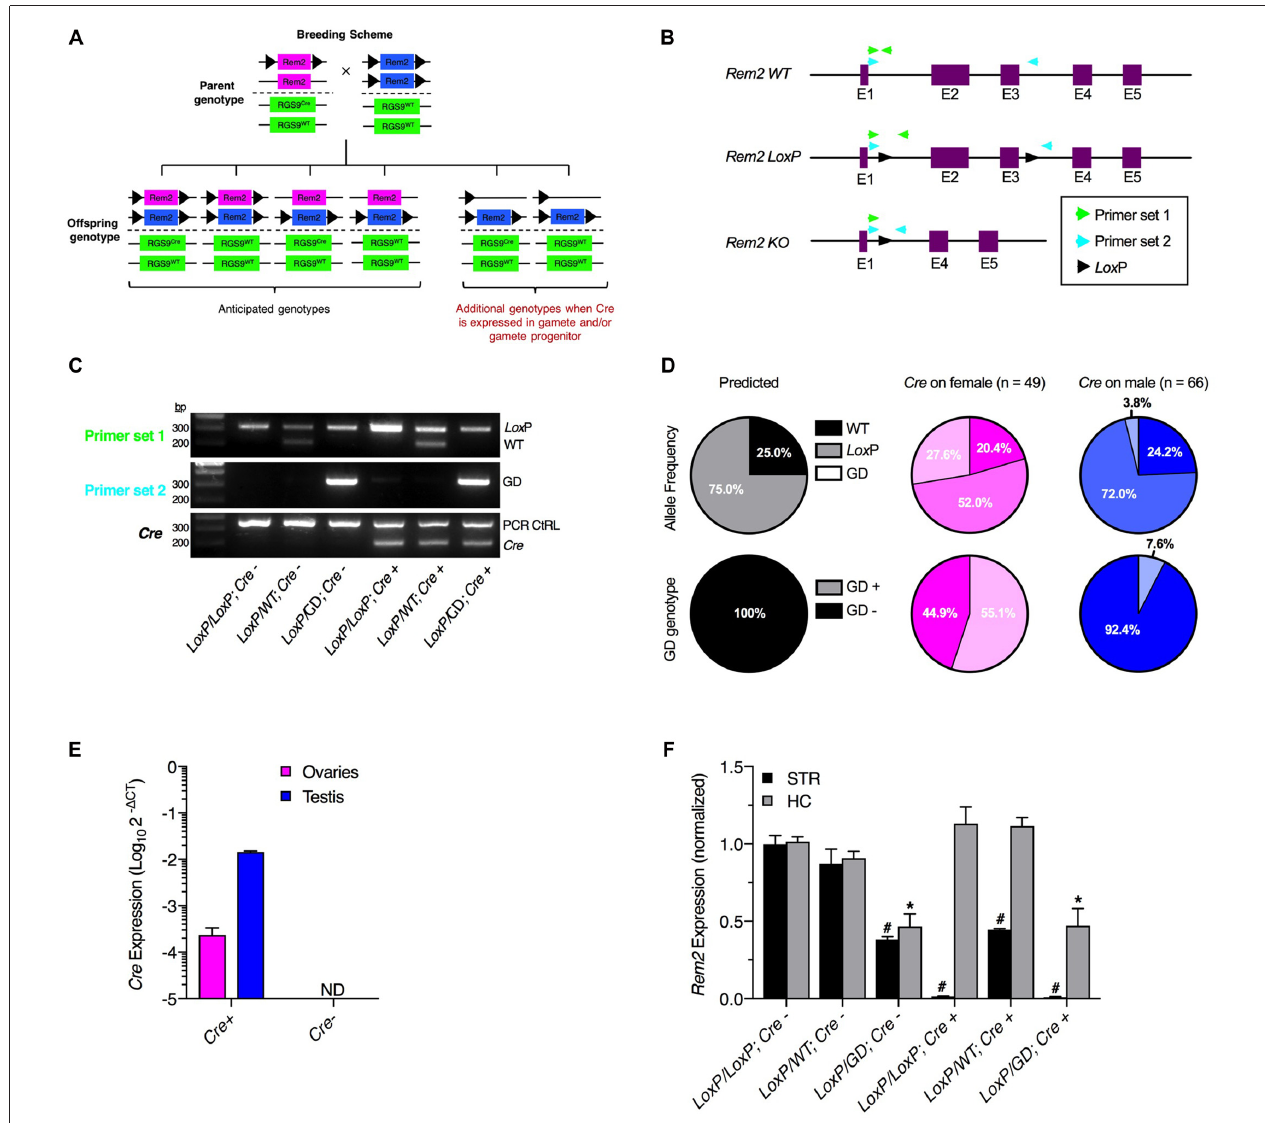
FIGURE 1 | Germline recombination of Rem2 conditional alleles by Rgs9cre driver mice. (A) Summary of anticipated and observed genotypes. (B) Schematic of Rem2 gene showing the wildtype allele, conditional allele with Lox P sequences flanking exons two and three, and knockout allele following Cre-recombinase (Cre) dependent deletion. Two primer sets were used to distinguish the three alleles. Primer set one flanked the 5 (cid:48) Lox P site, while primer set two flanked the entire floxed region. Note that the complementary DNA sequence for the reverse primer of Primer set 1 is excised following recombination, which results in failed polymerase chain reaction (PCR) amplification. (C) PCR results from genomic DNA (gDNA) purified from ear biopsies. PCR using primer set 1 produced two possible amplicons corresponding to the wildtype (221 bp) and Lox P conditional (327 bp) alleles. PCR with primer set 2 resulted in three possible amplicons corresponding to the wildtype (1,915 bp; not shown), Lox P conditional (2,065 bp; not shown), and Cre-dependent deleted (338 bp) alleles. The Cre PCR reaction contained primers within the Cre coding sequence (200 bp) and PCR control primers (350 bp). (D) Allele frequency and germline genotype frequency predicted for the